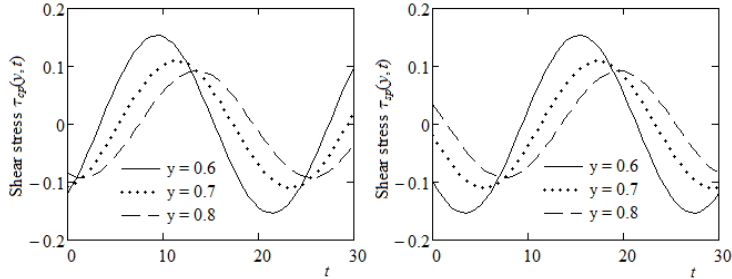
Figure 8. Time variations of the shear stresses τ cp ( y , t ) and τ sp ( y , t ) for Re = 100, We = 1, ω = π /12, α = 0.8 and increasing values of y